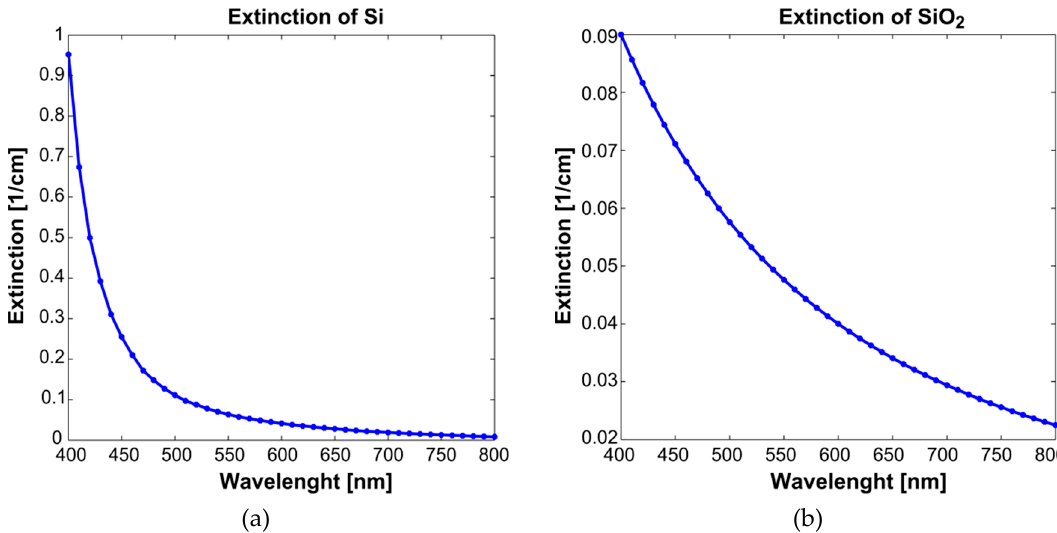
Figure 1. ( a ) The extinction coefficients of Si. Images adapted from Reference [14]. ( b ) The extinction coefficients of SiO 2. We adapted these images from Dobrowolska et al. [15].